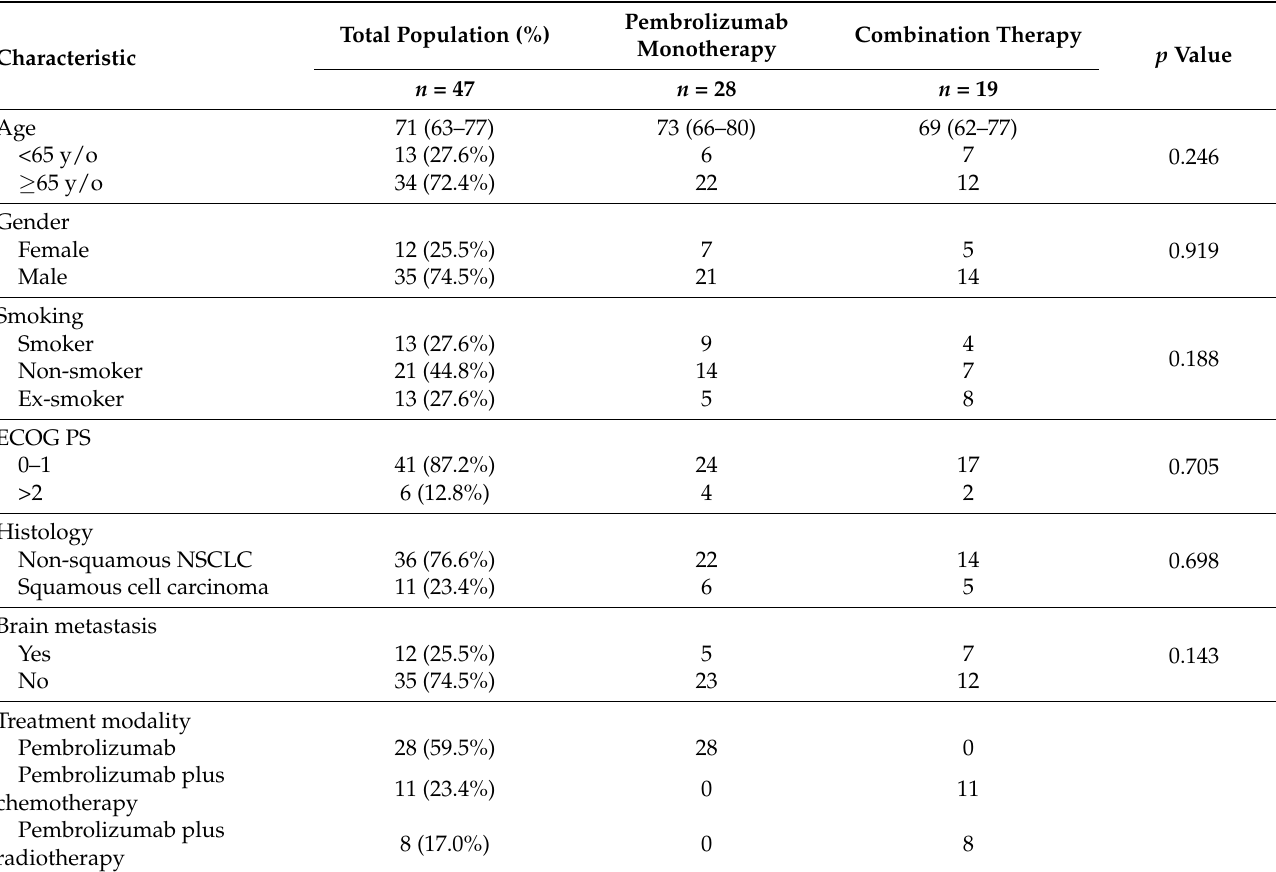
Figure 1. Flow chart describing enrollment of patients in the study. NSCLC, non-small cell lung cancer; PD-L1, programmed death ligand-1. Table 1. Clinical characteristics of all